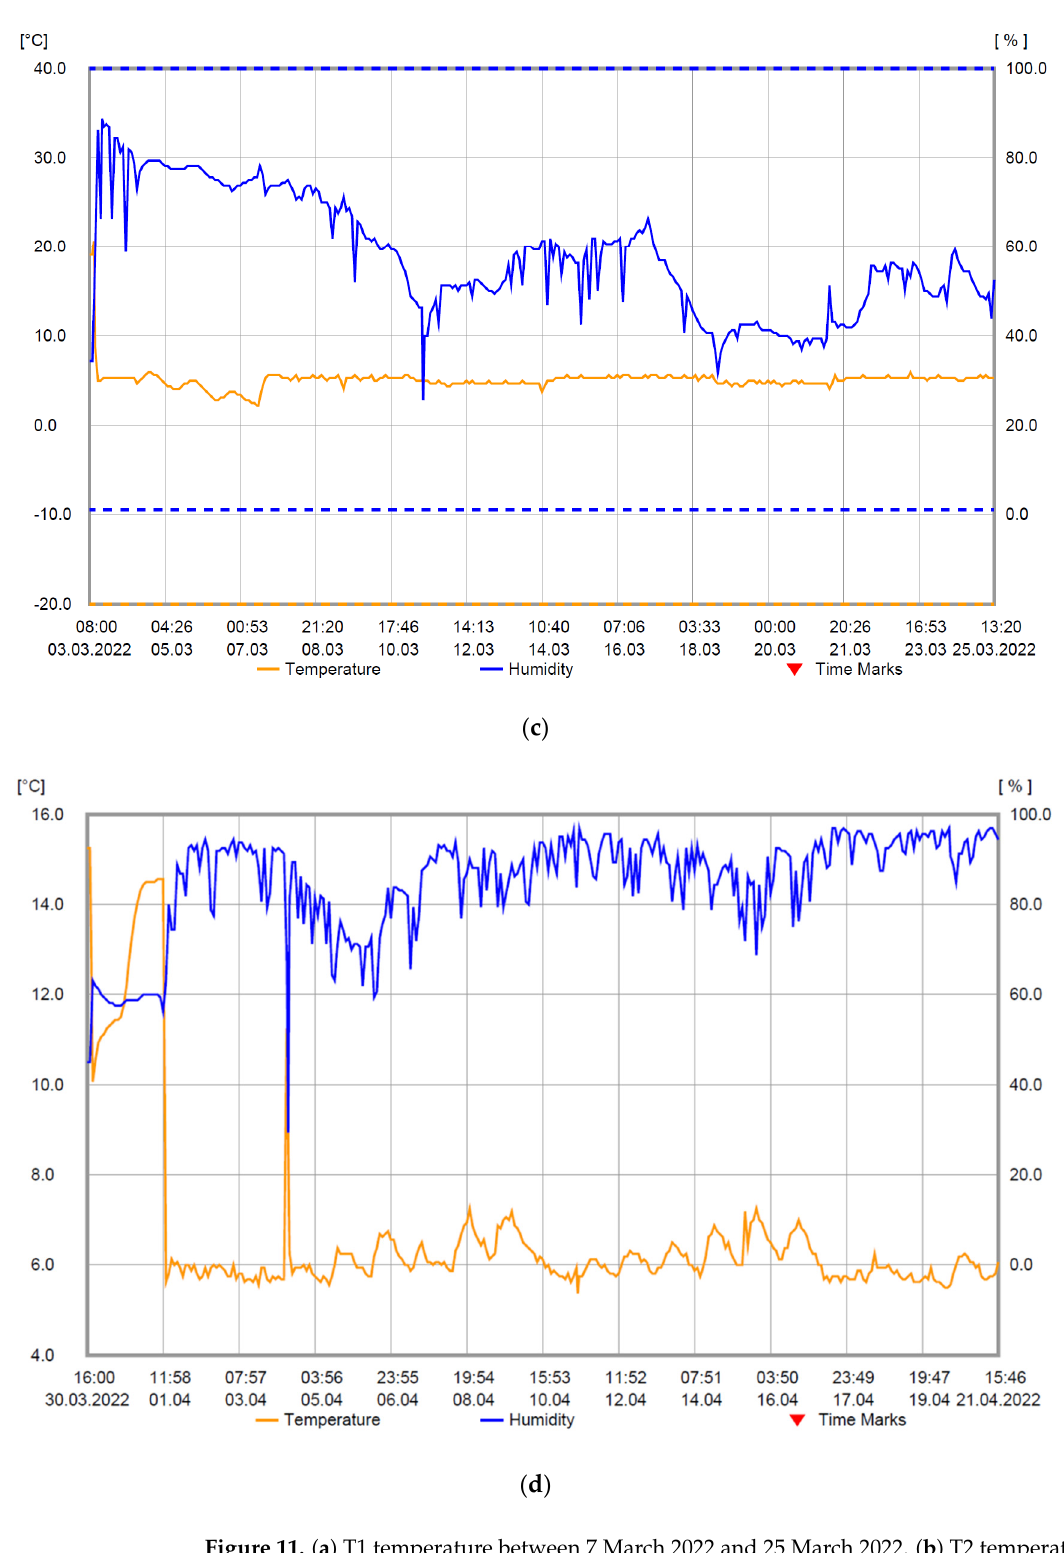
Figure 11. ( a ) T1 temperature between 7 March 2022 and 25 March 2022. ( b ) T2 temperature between 7 March 2022 and 25 March 2022. ( c ) T3 temperature between 7 March 2022 and 25 March 2022. ( d ) T1 temperature between 4 April and 21 April 2022 .